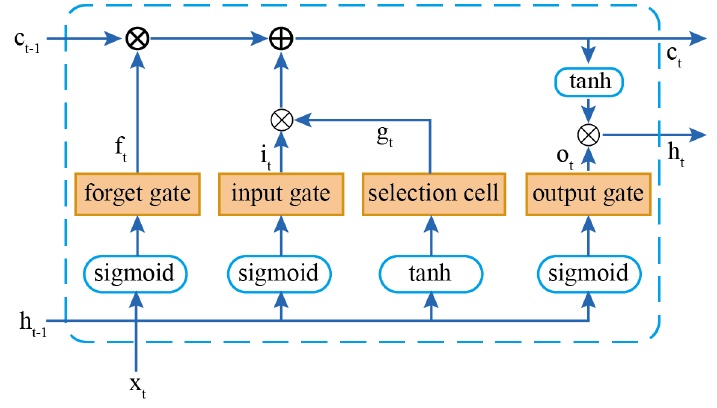
Figure 2. Illustration of Long short-term memory